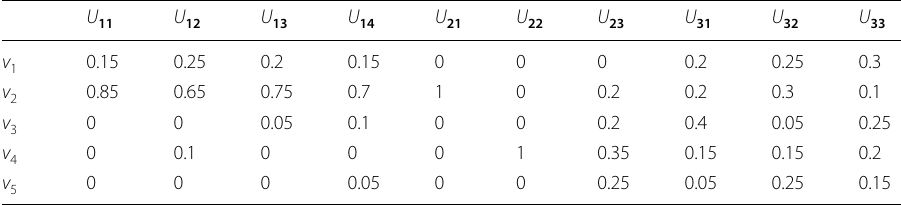
Table 4 Evaluation result of sewing operation